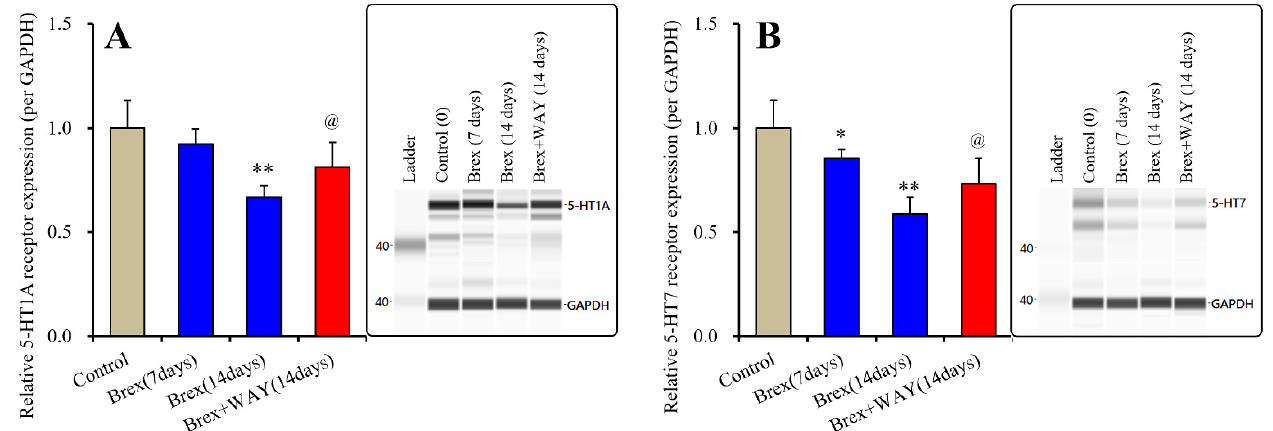
Figure 2. Effects of subchronic administration (7 and 14 days) of therapeutic relevant concentration of Brex (Brex: 300 nM) and interaction between Brex and 5-HT1A receptor (5-HT1AR) antagonist WAY100635 (WAY: 10 μ M) on protein expression of 5-HT1A (panel A ) and 5-HT7 (panel B ) receptor in the plasma membrane fraction of cortical primary cultured astrocytes. In left side histograms, ordinate: mean ± SD ( n = 6) of the relative protein level of 5-HT1AR and 5-HT7R per GAPDH. * p < 0.05, ** p < 0.01: relative to control (Brex-free) by one-way analysis of variance (ANOVA) with Tukey’s post-hoc test, and @ p < 0.05: relative to Brex for 14 days by Student’s T -test. Right side panels indicate their pseudo-gel images using capillary immunoblotting.